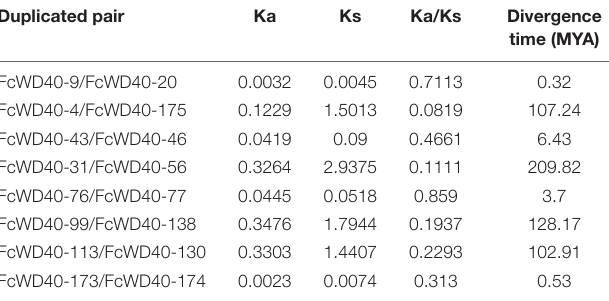
TABLE 1 | Ka/Ks calculation and divergence time of the duplicated FcWD40 gene pairs. Duplicated pair Ka Ks Ka/Ks Divergence